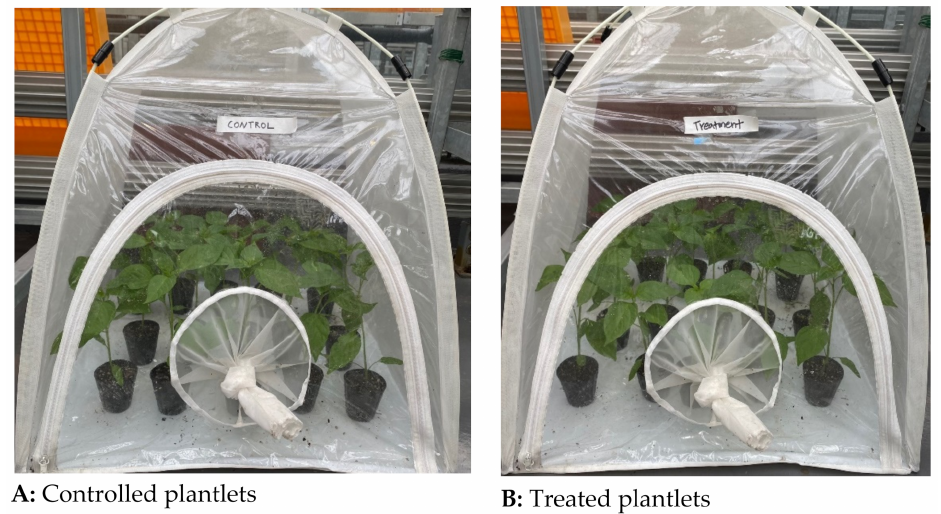
Figure 1. Controlled plantlets ( A ) and fungus-treated plantlets ( B ) under